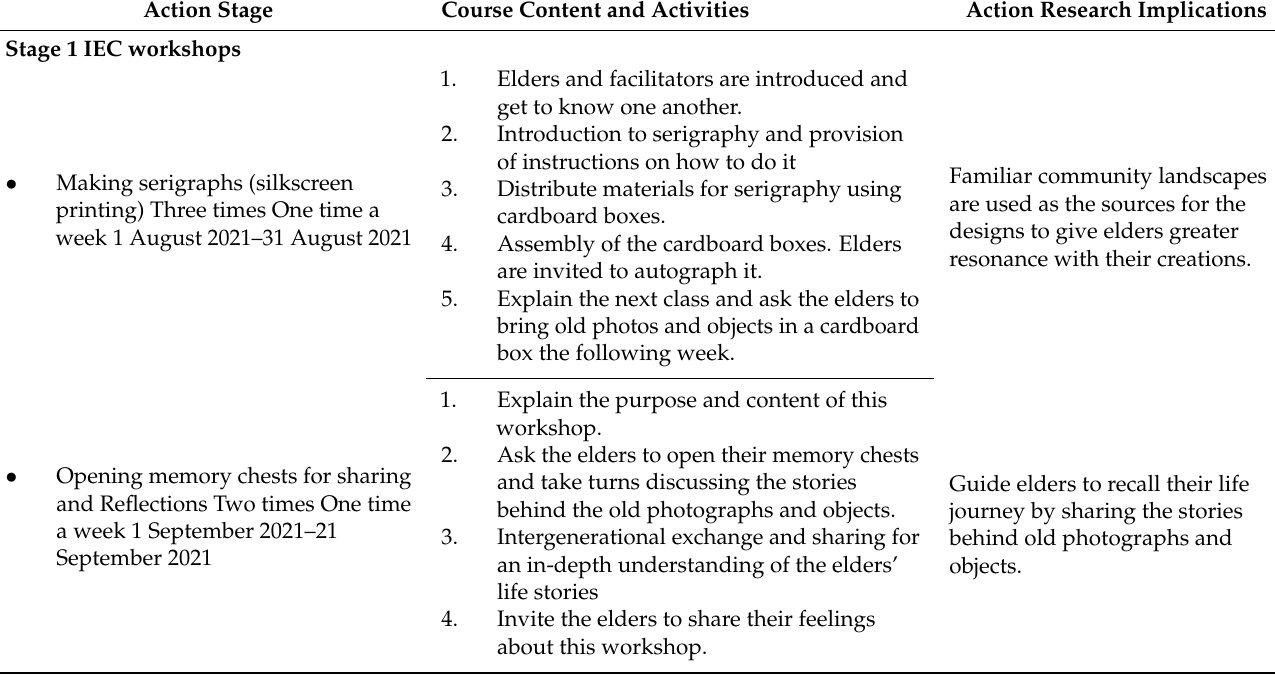
Table 1. IEC Workshop